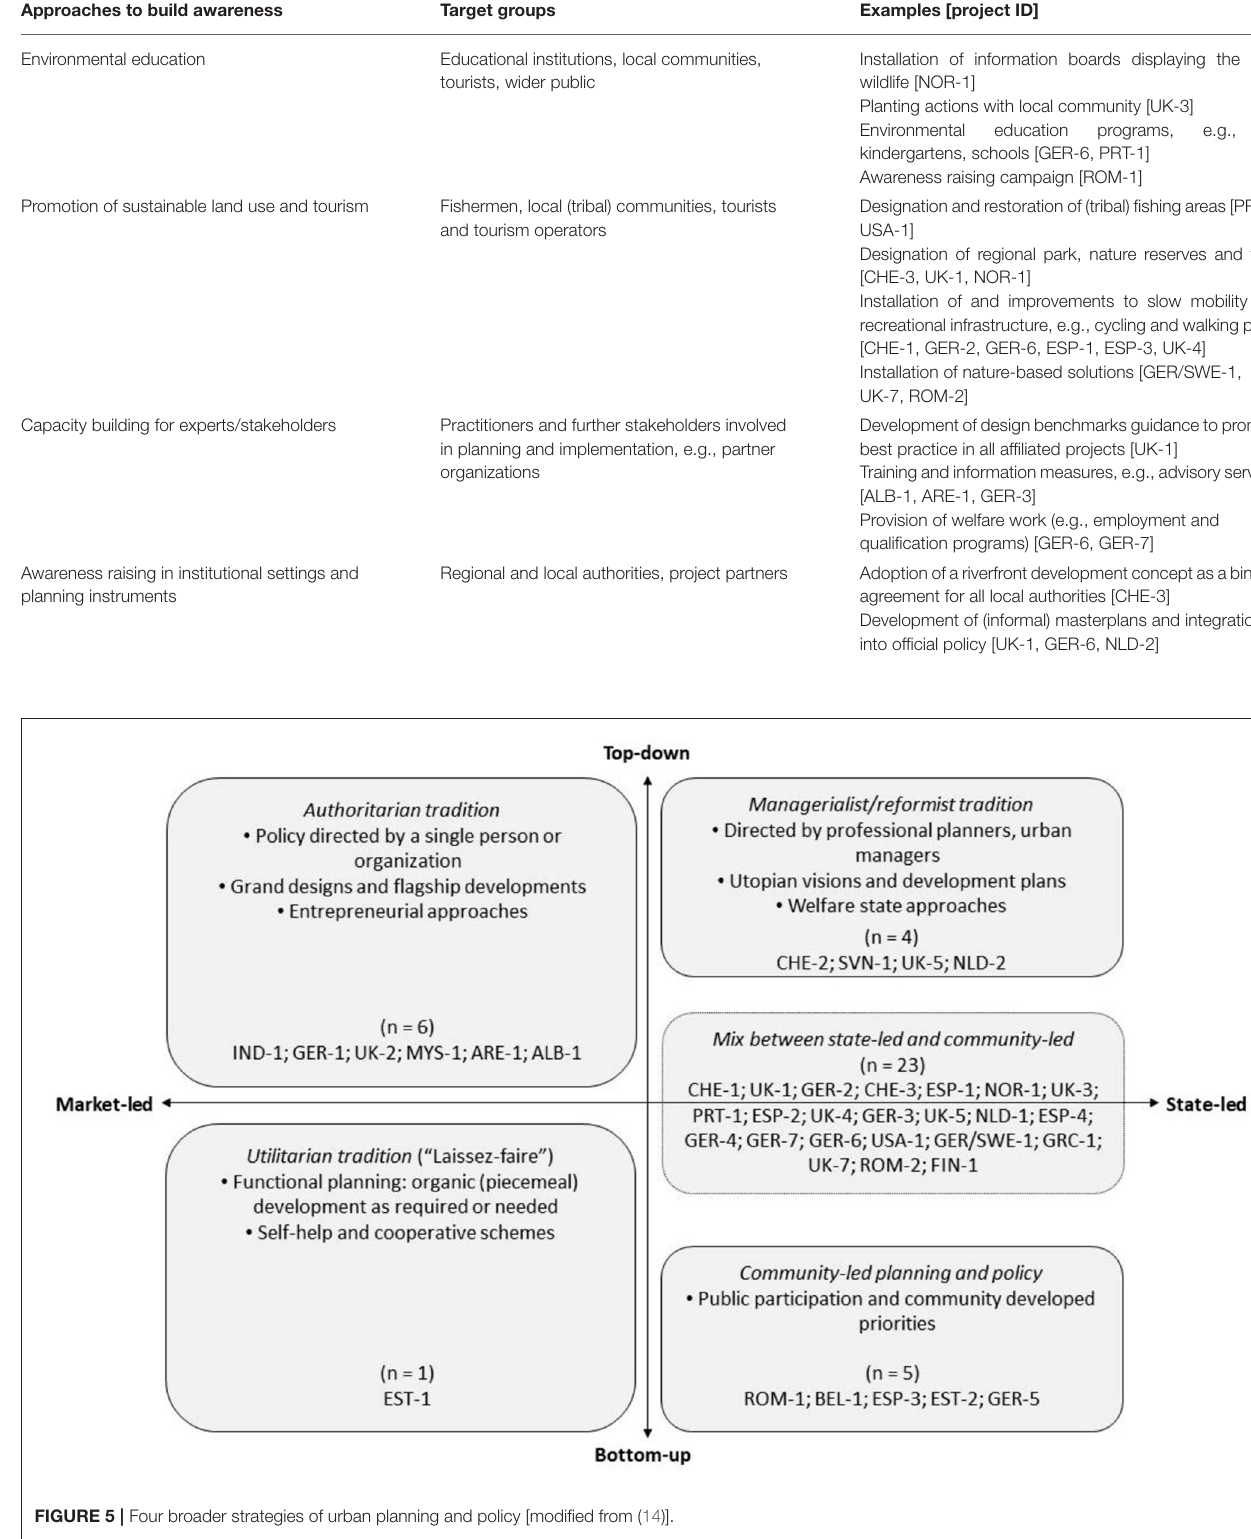
FIGURE 5 | Four broader strategies of urban planning and policy [modified from